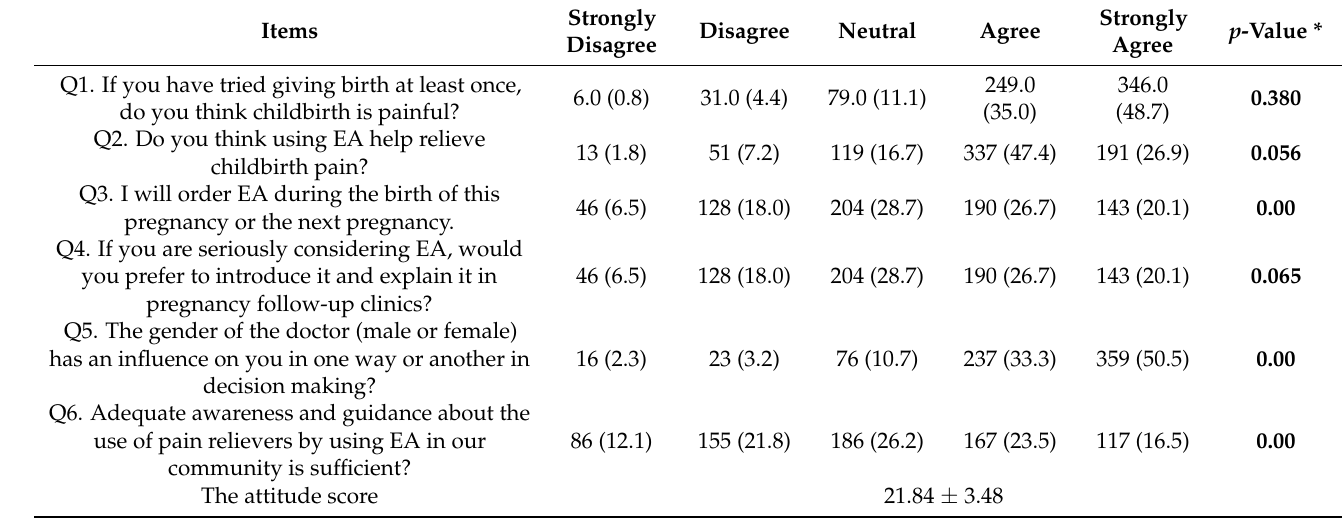
Table 3. Response to attitude questions for the whole samples and their association to age.